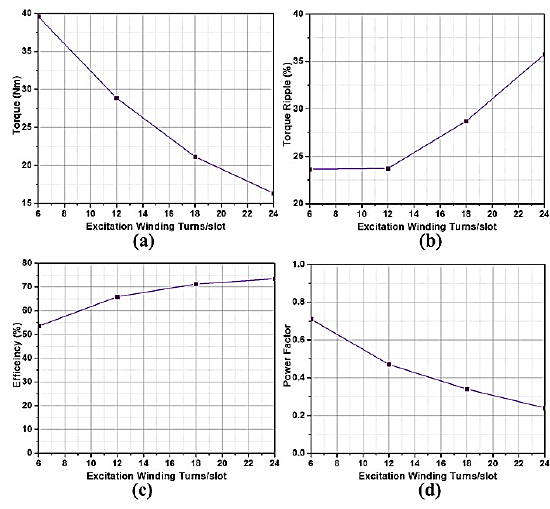
Figure 8. Effect of variation of excitation winding turns on machine performance ( a ) torque; ( b ) torque ripple; ( c ) efficiency; and ( d ) power factor.